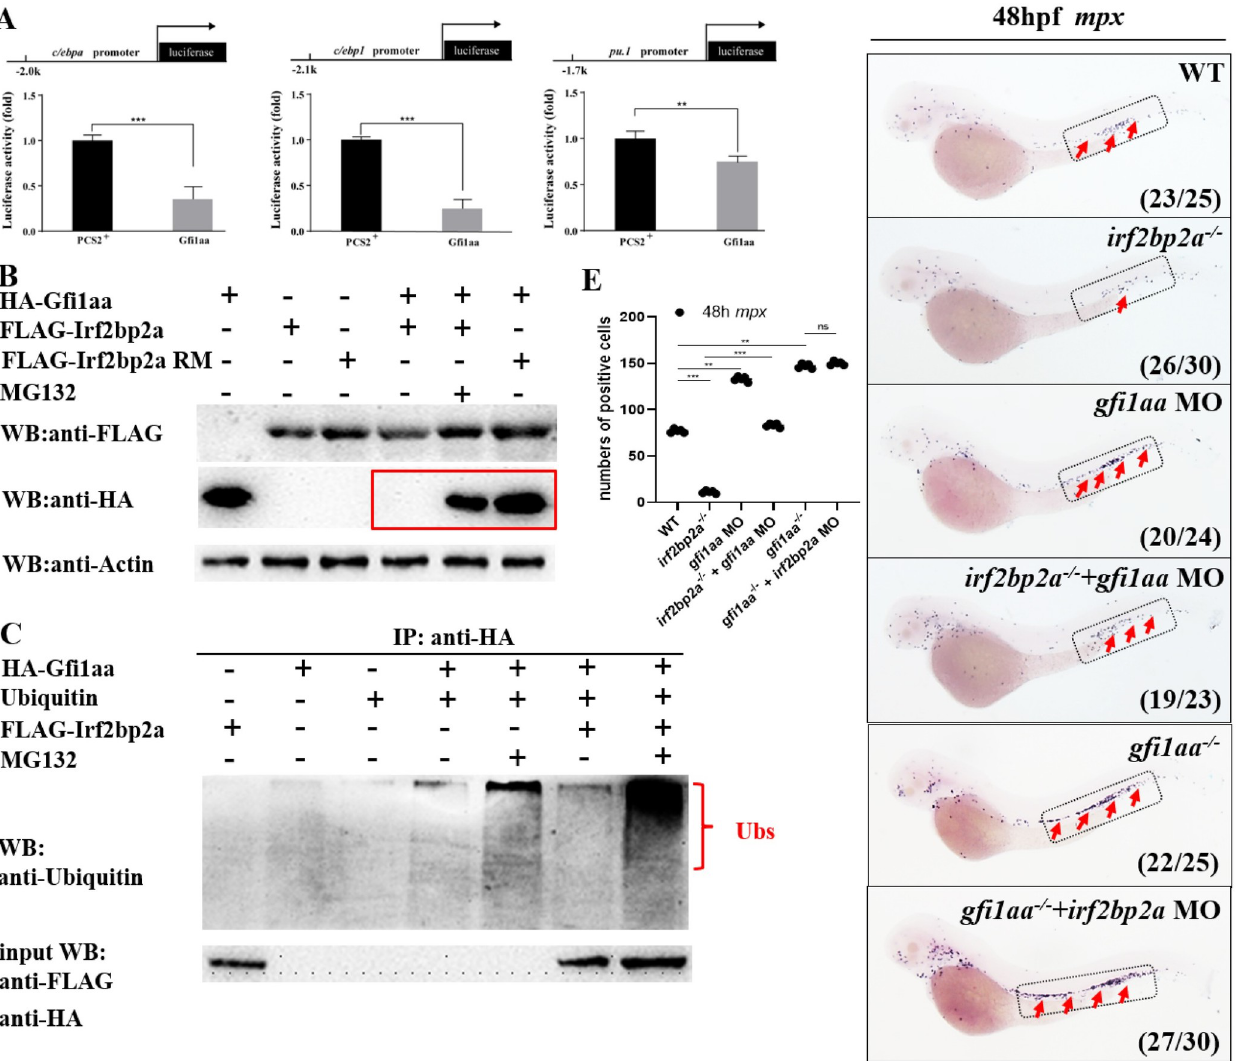
Fig 4. Irf2bp2a targets the transcription repressor Gfi1aa for ubiquitination and proteasomal degradation. (A) Luciferase reporter assay. Bars showed the relative luciferase activity on the zebrafish c/ebp α promoter (-2.0 kb), c/ebp1 promoter (-2.1 kb), and pu . 1 promoter (-1.7 kb) (Student t test, N = 3. Error bars represent mean ± SEM. �� P < 0.01, ��� P < 0.001). (B) Western blot analysis (anti-FLAG and anti-HA) of FLAG-Irf2bp2a, FLAG-Irf2bp2a RM, and HA-Gfi1aa expressed in HEK293 cells. The proteasome inhibitor MG132 (2.5 μ M) was used to inhibit the degradation of ubiquitinated proteins. Equal protein amounts for each sample were loaded (anti-Actin). (C) HA-Gfi1aa protein was immunoprecipitated (IP) with an anti-HA antibody from HEK293 cells co-expressing Ubiquitin and FLAG-Irf2bp2a. Many more adducts of Ubiquitin were detected by western blot with an anti-Ubiquitin antibody. (D) WISH assay of mpx in WT, irf2bp2a -/- mutant embryos, wild type and irf2bp2a -/- mutant embryos injected with gfi1aa MO, gfi1aa -/- embryos, and gfi1aa -/- embryos injected with irf2bp2a MO. (E) Statistic result for D. The statistical significance was calculated by using one-way ANOVA. The asterisk indicates a statistical difference (N = 5, 19–30 embryos were used for each experiment. Each dot represents the mean value of one experiment. Error bars represent mean ± SEM. �� P < 0.01; ��� P < 0.001). proteasome inhibitor MG132 (Fig 4B). By contrast, Gfi1aa protein existed with co-transfection of Irf2bp2a RM without MG132 treatment (Fig 4B). Next, additional experiments were per- formed to further confirm the effect of Irf2bp2a on Gfi1aa ubiquitination and proteasomal degradation. HEK293 cells were transfected with HA-Gfi1aa, Ubiquitin (Ub), and with or without FLAG-Irf2bp2a. After immunoprecipitation (IP) with an anti-HA antibody, western blot detected by anti-Ubiquitin revealed that pull-downed Gfi1aa protein was intensively